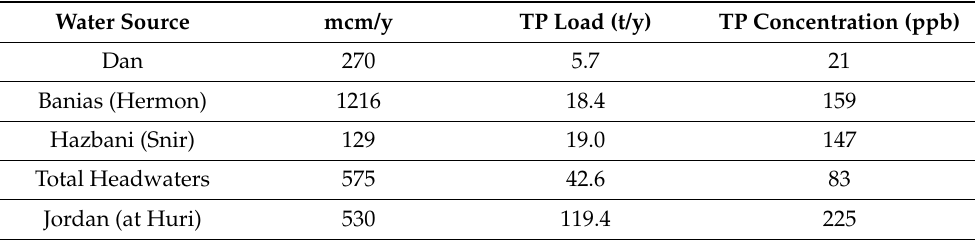
Table 7. Multi-annual (1967–1985) averages for Jordan River and three headwater rivers: Dan, Banias (Hermon), and Hazbani (Snir) (Figure 1). Annual discharge (mcm/y) and TP concentration (ppb) averaged for the three headwaters are shown. Data Sources: National Water Authority-National Hydrological Service; Mekorot Water Supply Company,